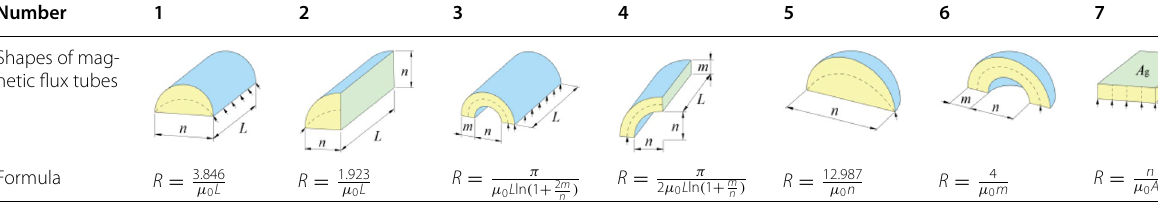
Table 1 Reluctance calculation of various magnetic flux tubes Number Shapes of mag- netic flux tubes